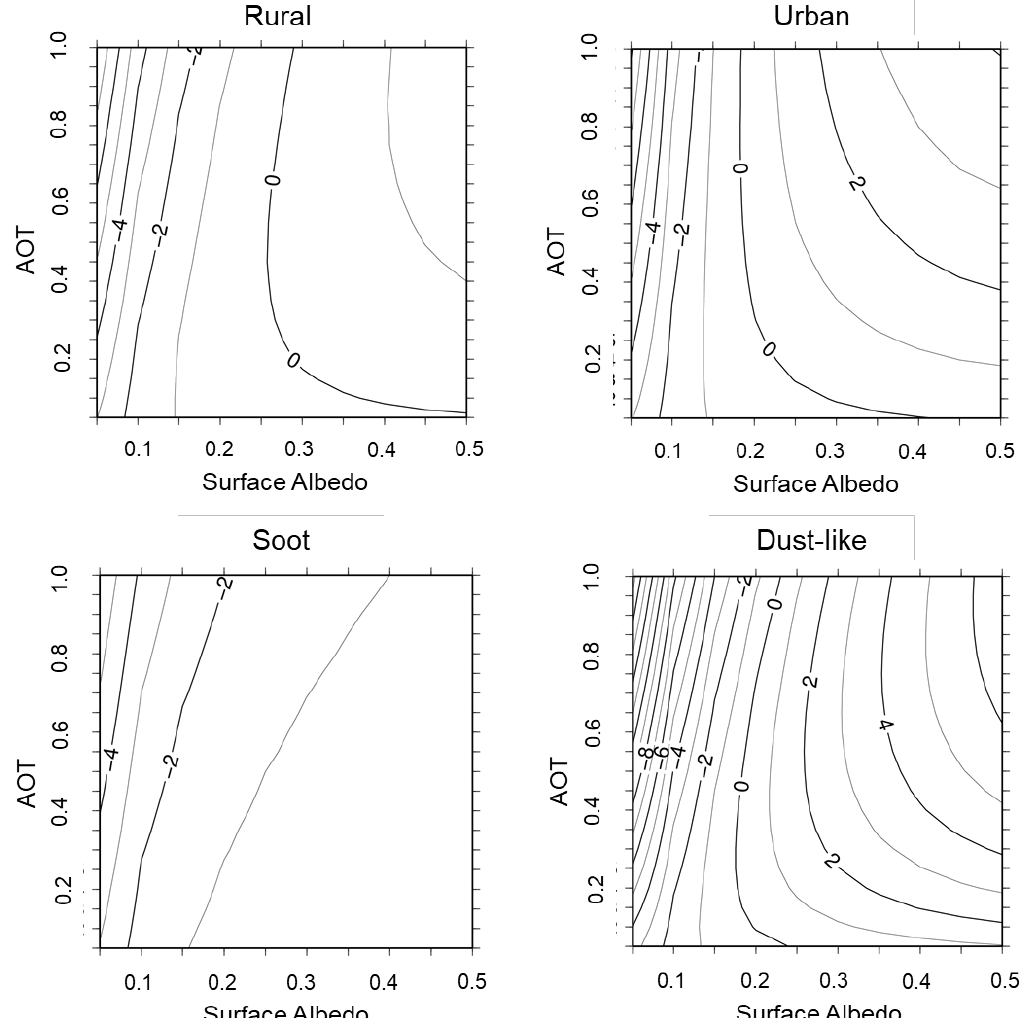
Figure 5. XCO 2 biases calculated for various combinations of surface albedo and AOT. Units are parts per million.